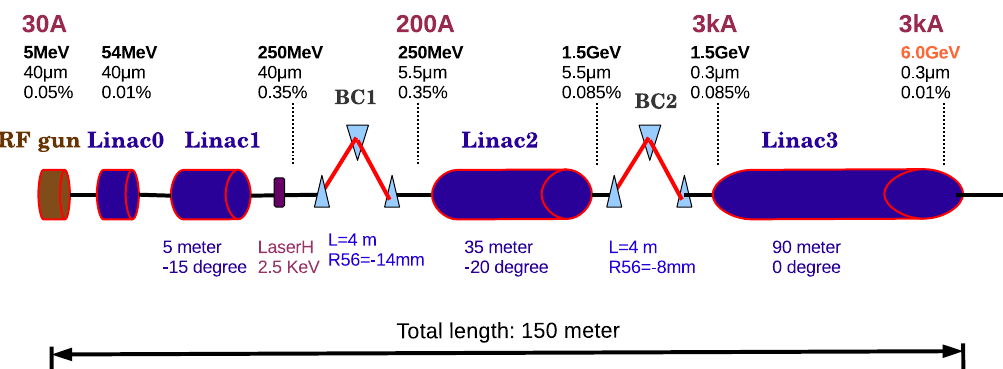
FIG. 1. Sketch of a compact (150 m) hard x-ray FEL driver using all X -band accelerators, from X -band photoinjector to X -band linac end. An average real estate acceleration gradient of 60 MV = m is assumed in the X -band accelerator structures, and two stage bunch compression system is adopted with relatively weak dipole magnets to suppress incoherent and coherent synchrotron radiation (ISR and CSR) effects. The linac for the hard x-ray FEL design has a final electron bunch energy of 6 GeV with a peak current of 3 kA, while the soft x-ray FEL design has 2 GeV, 1 kA electron bunches. A final pulse duration length of 2 to 6 fs is achieved with a bunch charge of 10 pC. The slice energy spread is between 0.01%–0.02%, and the slice normalized transverse emittance is below 0 : 2 (cid:1) m .